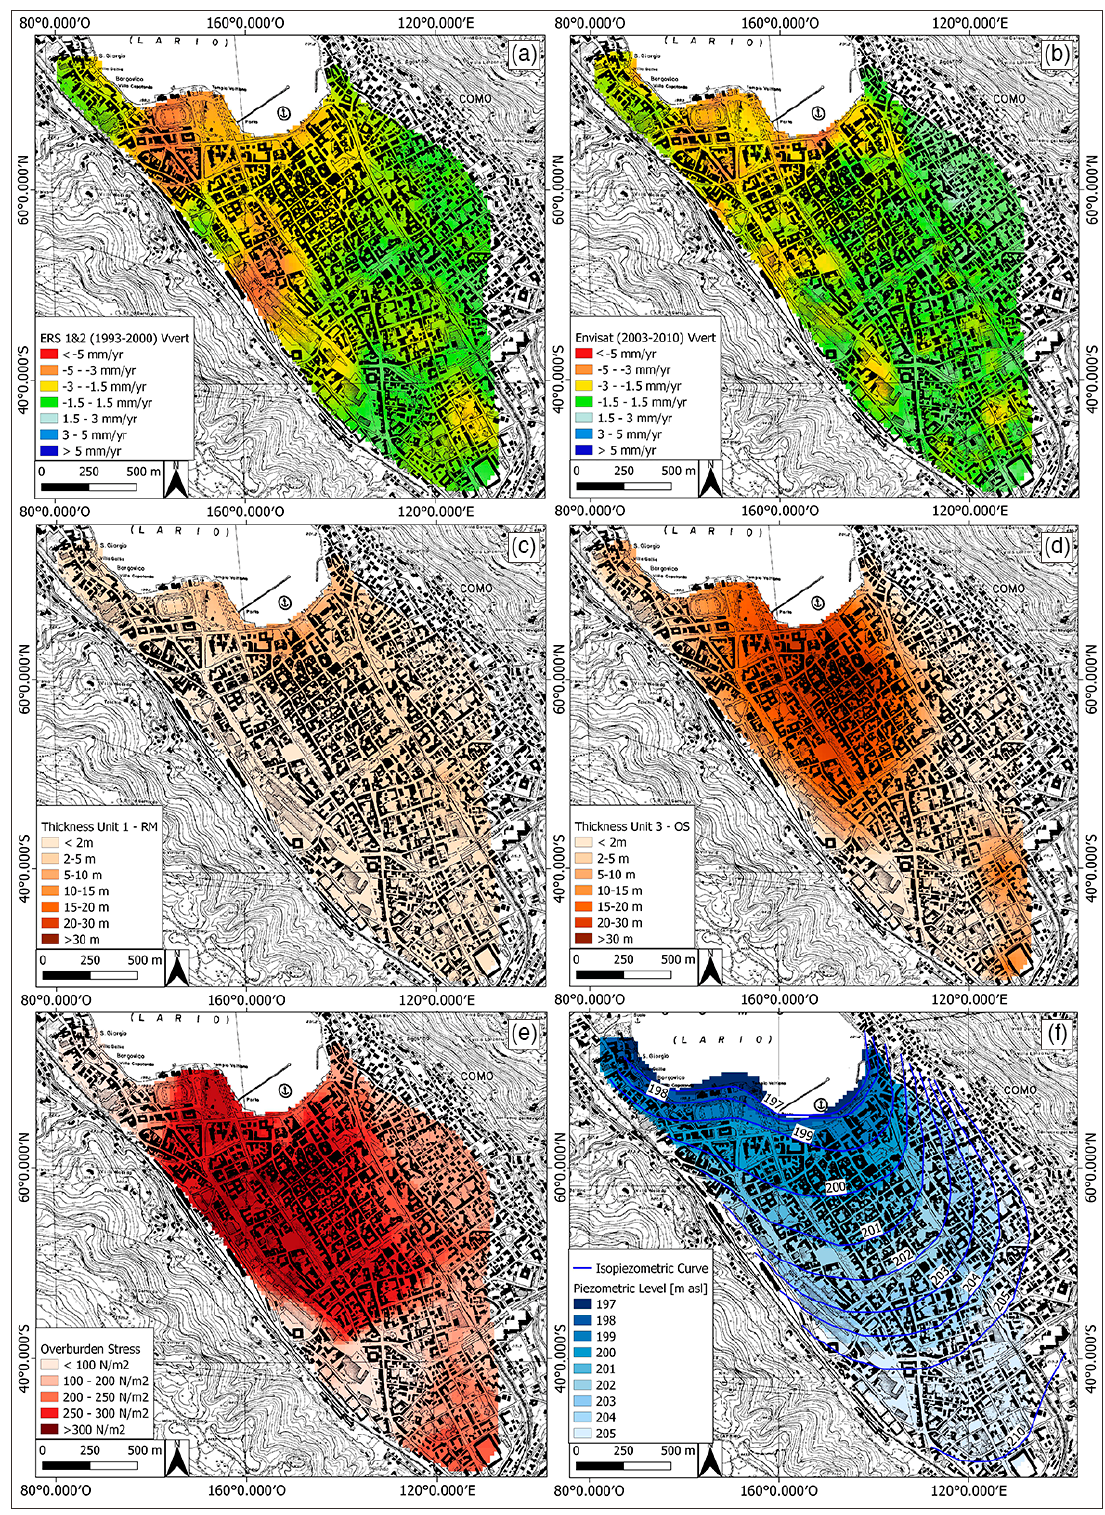
Figure 5. Results for the ordinary Kriging interpolation of ( a ) ERS 1 and 2 (1992–2000) and ( b ) Envisat (2003–2010) vertical velocity (V vert ) expressed in mm / year [mm / yr]. Results of the Empirical Bayesian Kriging (EBK) interpolation of ( c ) the thickness of unit 1 (reworked material—RM), ( d ) the thickness of unit 3 (organic silts—OS), ( e ) the overburden stress ( σ v ) value, and ( f ) the piezometric level expressed in meters above the sea level [m asl]. Blue lines represent the curves of the equal piezometric level of the phreatic aquifer (modified from [37]).